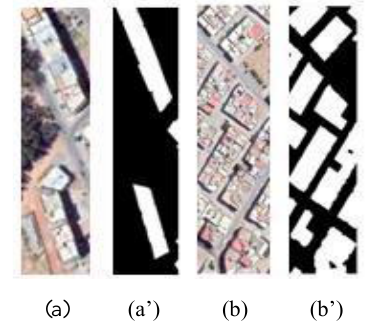
Fig.4. The detailed comparison between two binary building mask